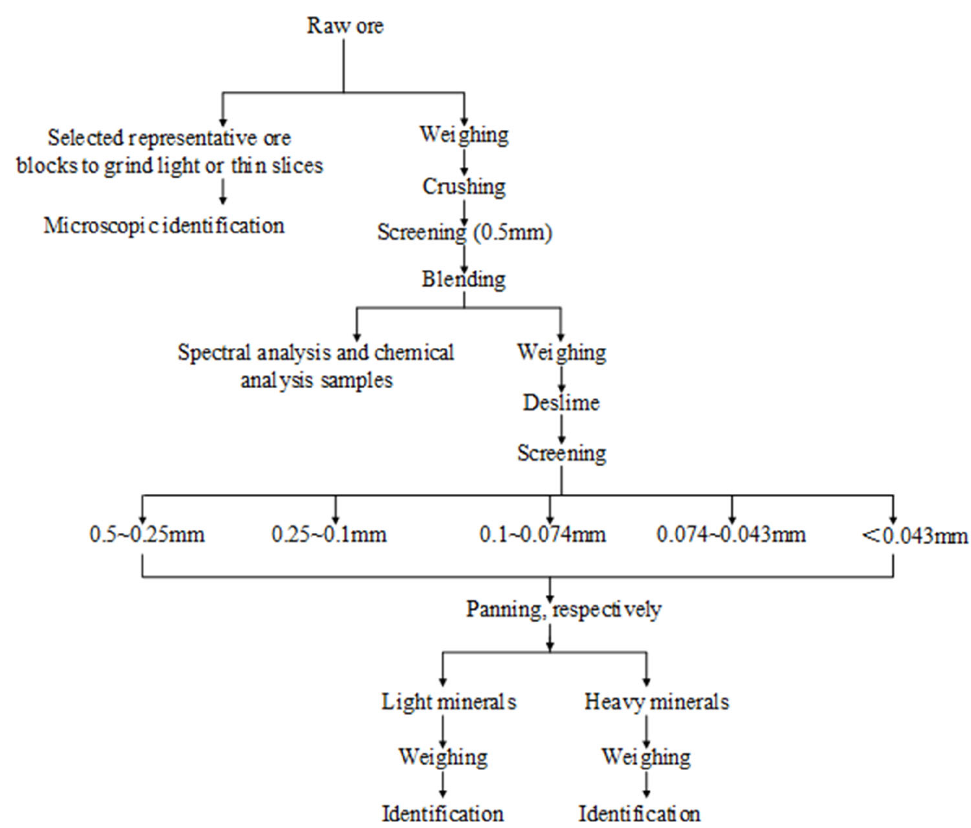
Figure 1. Artificial panning